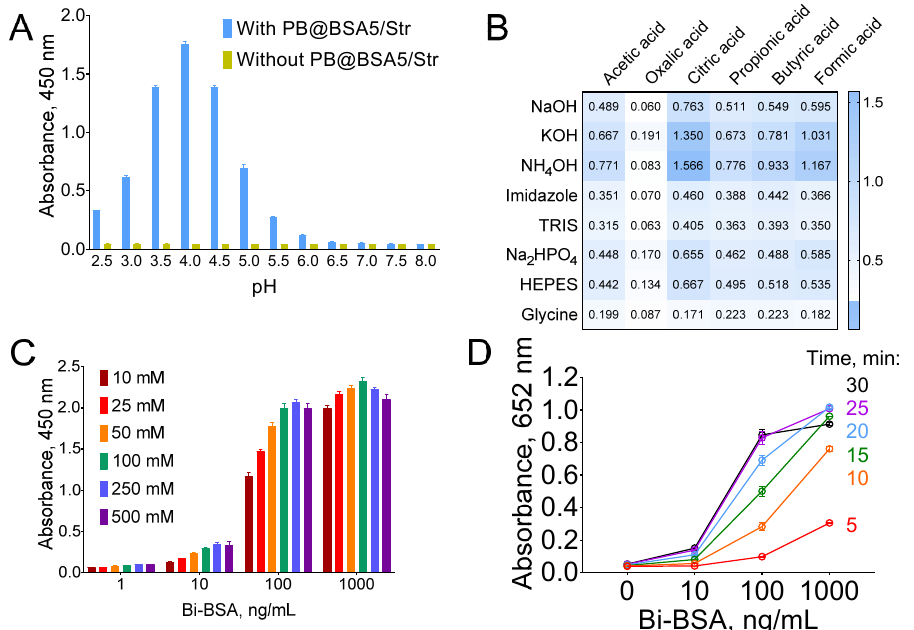
Figure 5. ( A ) Absorbance value produced by substrates with various pH values. Samples ‘Without PB@BSA5/Str’ represent signal intensity in wells that were filled with the blocking buffer instead of conjugate (control of spontaneous color development). Substrate: 0.1 M citrate/0.2 M phosphate buffers, TMB—1 mg/mL, H 2 O 2 —0.3%. n = 4, mean ± SD. ( B ) Absorbance value produced by various substrate buffers (pH 4), mean of 2 samples is given; ( C ) effect of buffer molarity on color signal, n = 3, mean ± SD; ( D ) calibration curves obtained in different time periods after the addition of substrate (H 2 O 2 -0.3%), n = 3, mean ± SD.